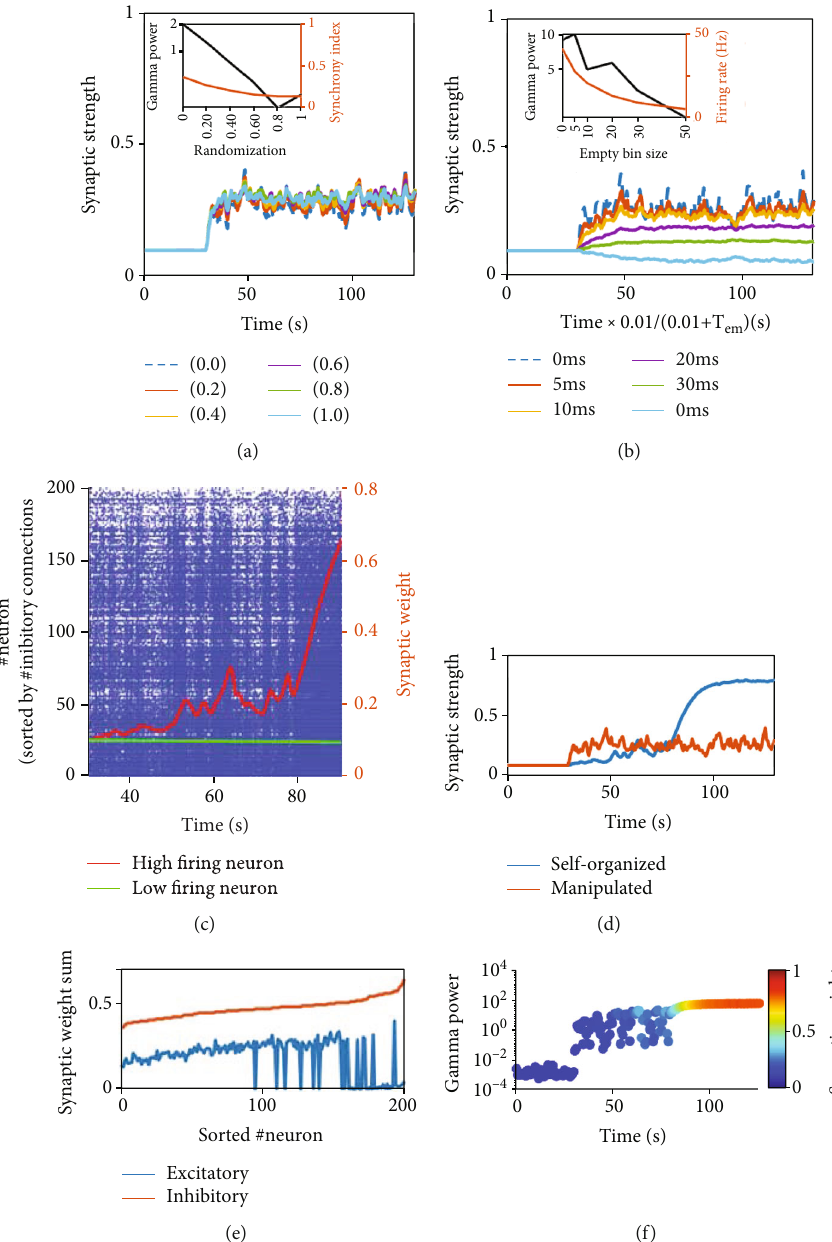
Figure 8: The dynamic properties of learning under moderate synchronous state. (a, b) E ff ect of fi ring rate and synchrony on synaptic weight evolution under plasticity with spike manipulation. (a) The e ff ect of spike time randomization. (b) The e ff ect of empty bin inserting. (c) Raster plot. Neuron number is sorted in an increasing order of inhibitory input connections. Red curve is the mean excitatory synaptic strength of high fi ring neurons, which increases during synchronous windows and decreases during asynchronous windows. Green curve is the mean excitatory synaptic strength of low fi ring neurons. (d) The synaptic weight evolution. (e) Sum of incoming excitatory and inhibitory synaptic weight of neurons in the plastic circuit after learning, sorted according to the ascending of inhibitory sum. (f) The evolution of gamma oscillation and synaptic weight in moderately synchronous